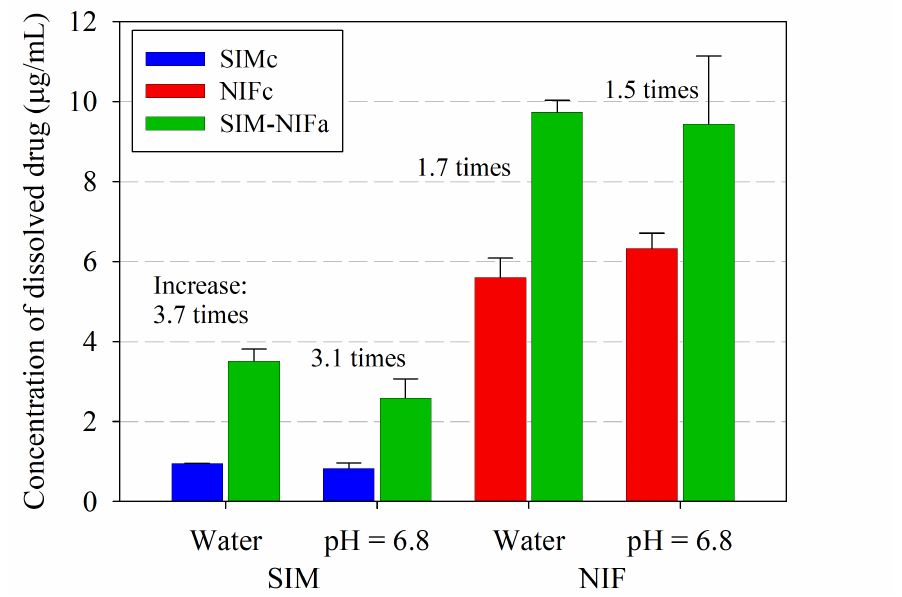
Figure 7. Comparison of maximum solubility values of pure APIs in their crystalline form (SIMc and NIFc) and co-amorphous formulation (SIM-NIF). Maximum solubility values shown were obtained in two different media: deionized water and a controlled pH medium using USP phosphate buffer (pH = 6.8). Table 3. Experimental values for the concentration of the dissolved drug in deionized water